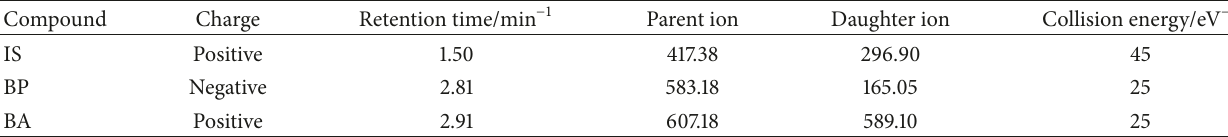
Table 1: MS parameters for BP, BA, and IS.